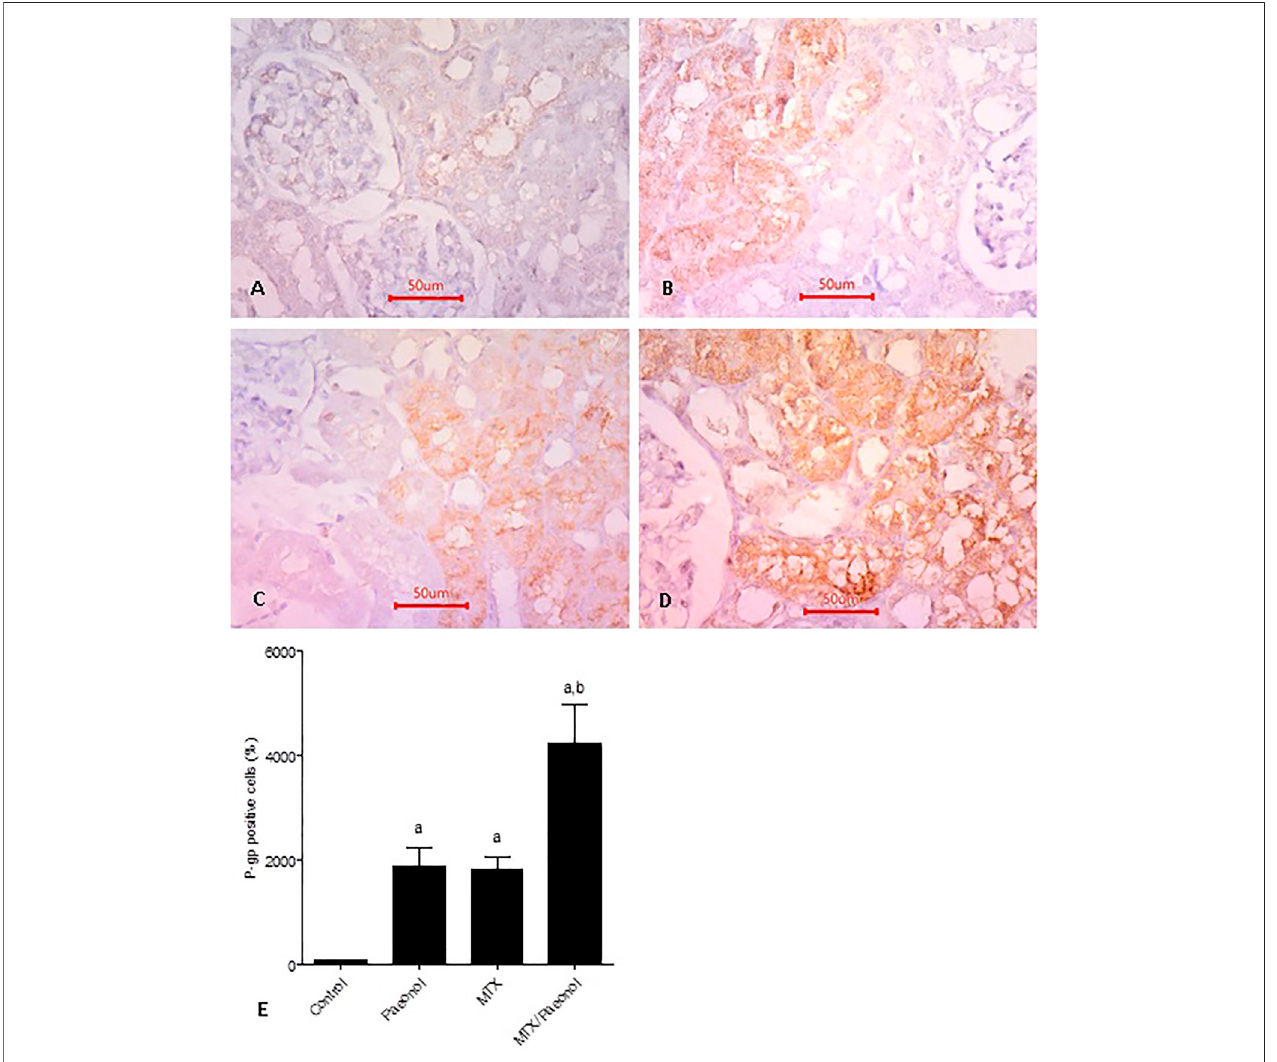
FIGURE 7 | P-glycoprotein (P-gp) renal expression level in the rat kidney after methotrexate (MTX) and/or paeonol administration. P-gp antibody – stained sections of the rat kidney (×400) from (A) control, (B) paeonol-treated, (C) MTX-treated, and (D) MTX/paeonol-treated rats. (E) Percent of positive cells compared to the control group, obtained from sections of each animal ( n = 6 for each group), six fi elds/section, where results were considered signi fi cantly different when p < .05. a,b Signi fi cant difference compared to control or MTX groups, respectively.